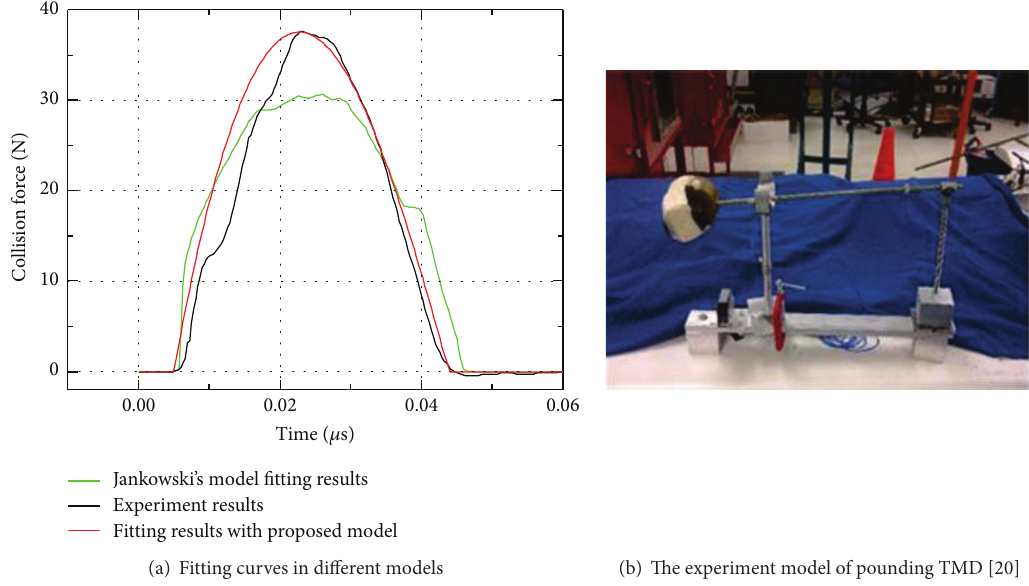
Figure 12: Pounding TMD experimental configuration and fitting curves by different methods.